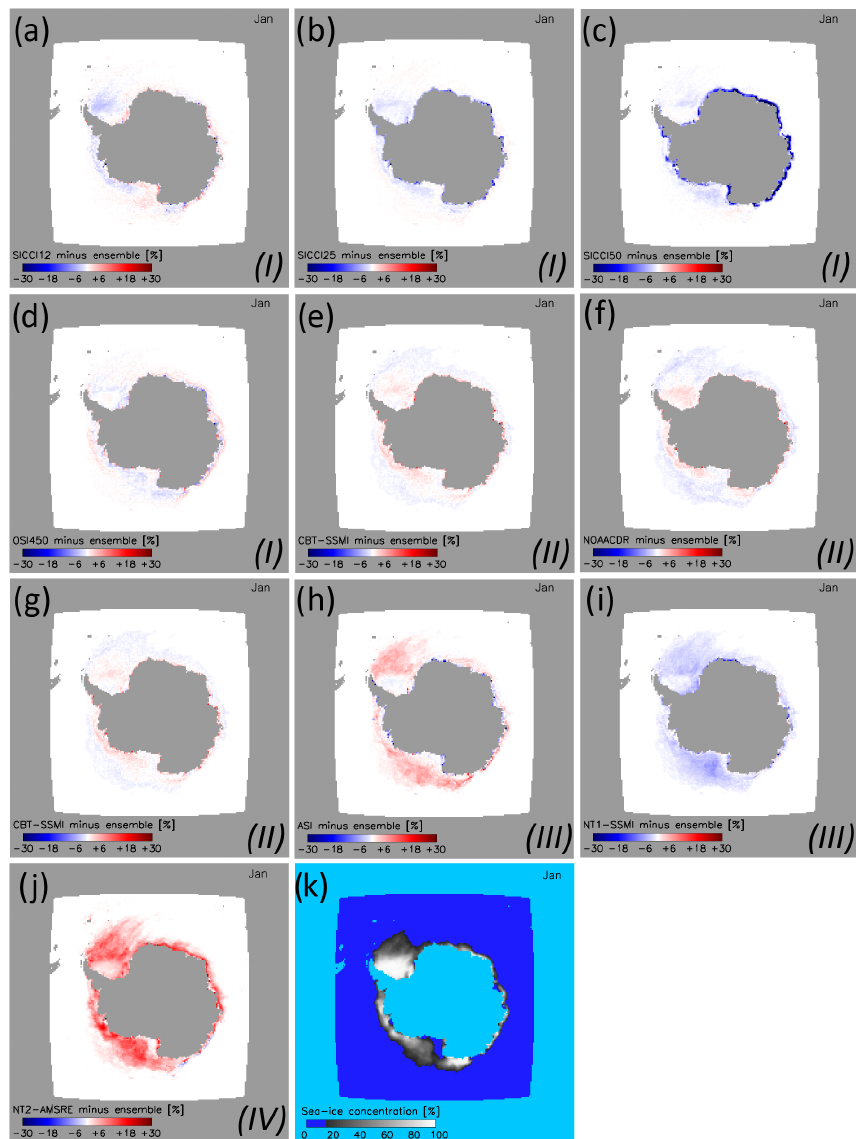
Figure 11. As Fig. 10 but in summer (January)